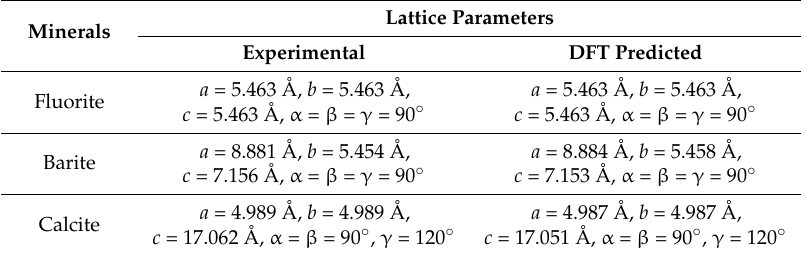
Table 2. Comparison of the lattice parameters for fluorite, barite and calcite obtained from Density Functional Theory (DFT) calculations and XRD